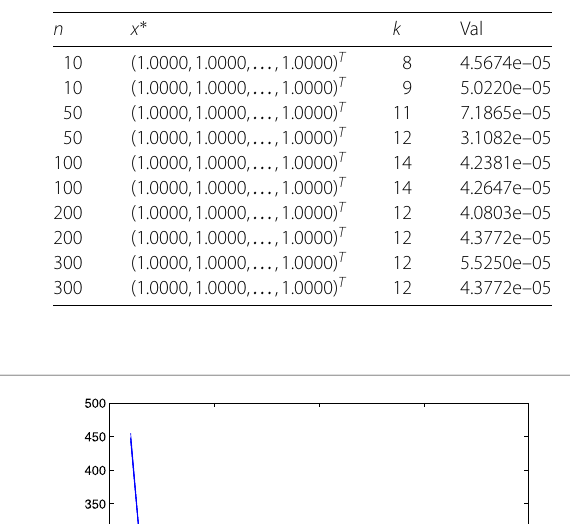
Table 3 Numerical results for Example